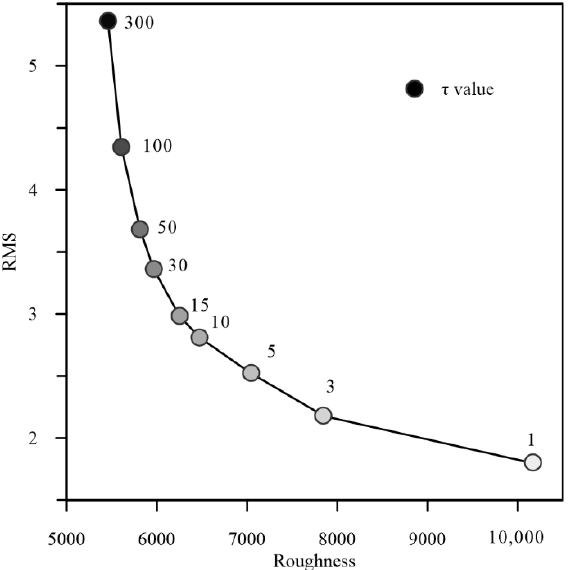
Figure 6. Model roughness and RMS curve (L-curve) obtained by inversion of different regularization factors (the different gray shades of each point represent different τ values, and the color becomes darker as the τ value becomes larger).